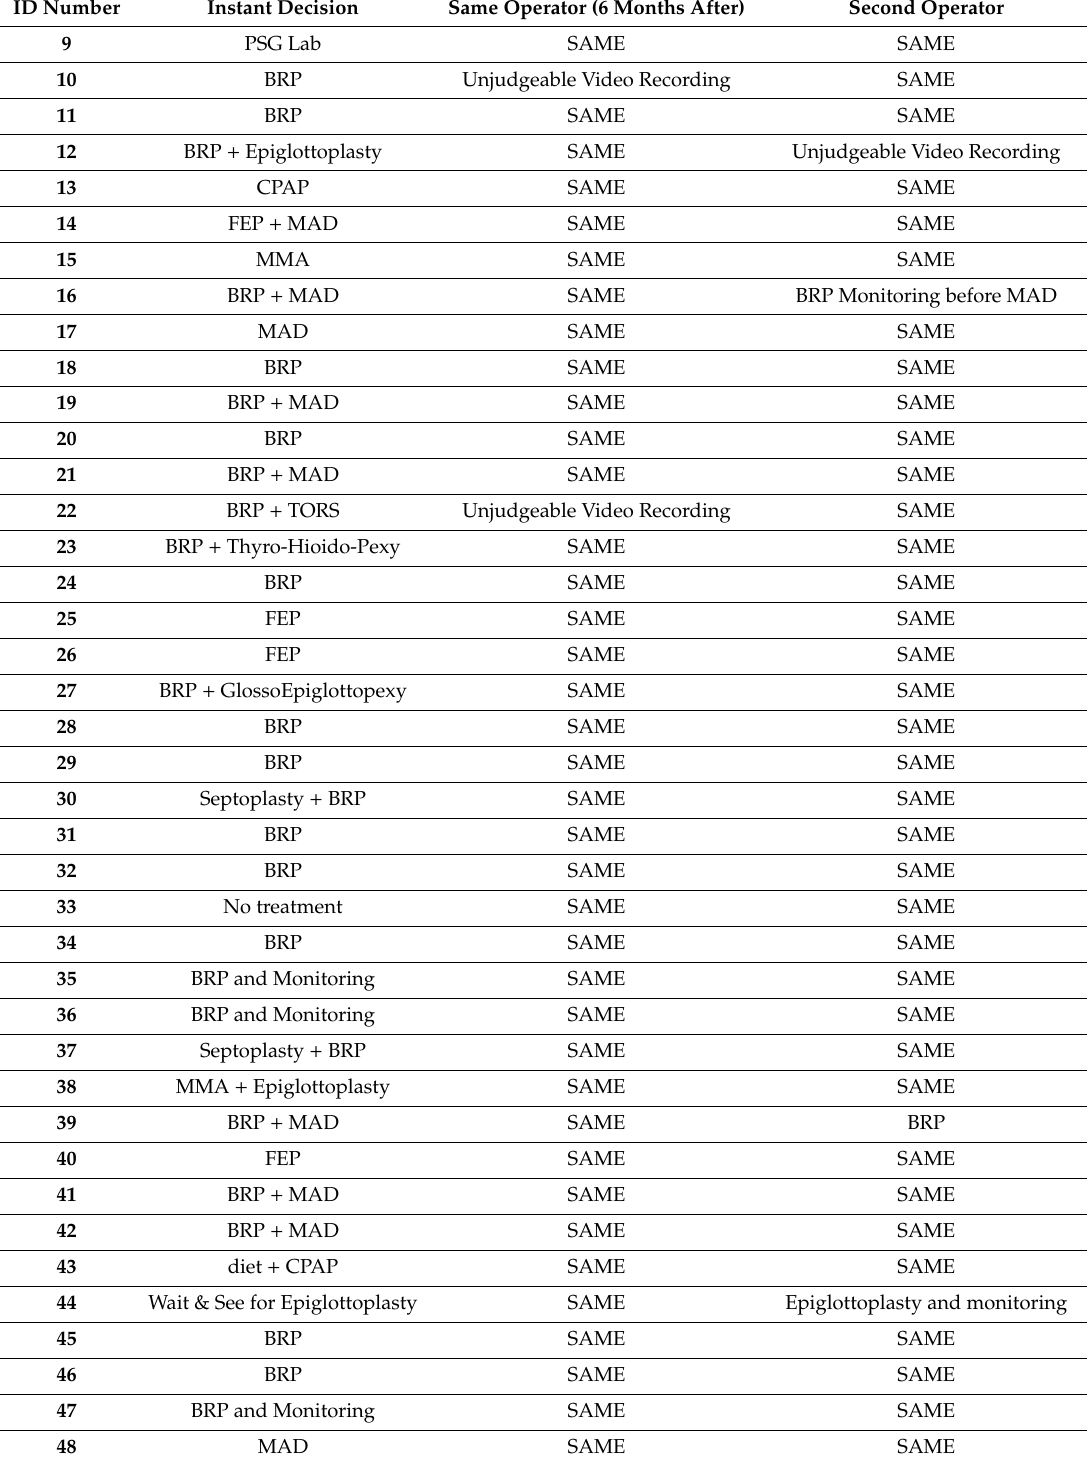
FEP: Functional expansion pharyngoplasty; PSG-lab: polysomnography in laboratory; BRP: barbed reposition pharyngoplasty; MAD: mandibular advancement device; MMA: maxillo-mandibular advancement; TORS: trans-oral robotic surgery; CPAP: continuous positive airway